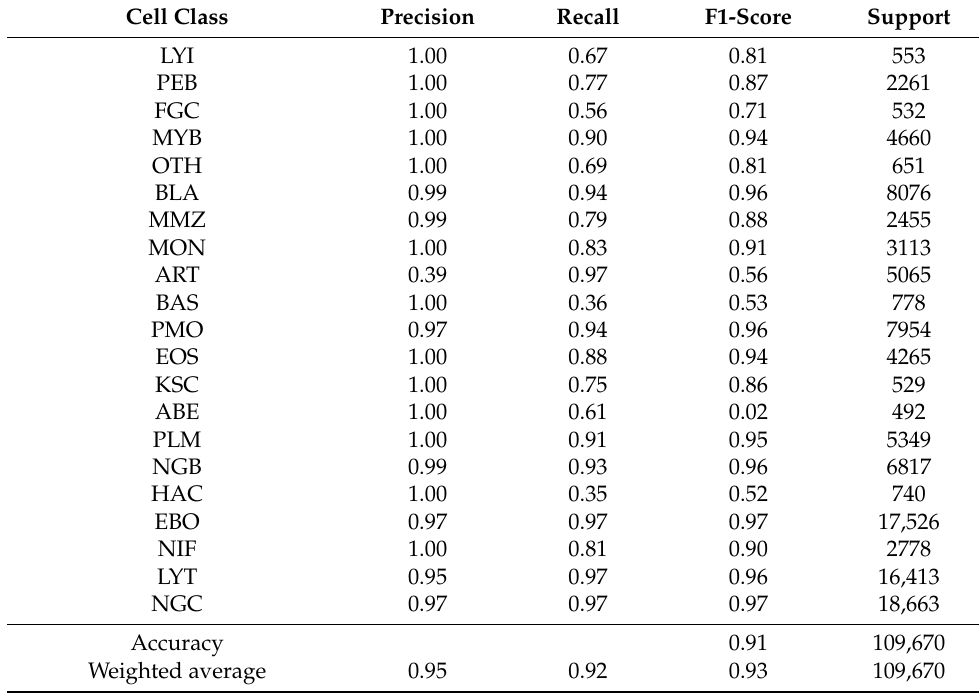
Table 3. Evaluation metrics score for different cell classes on train data.